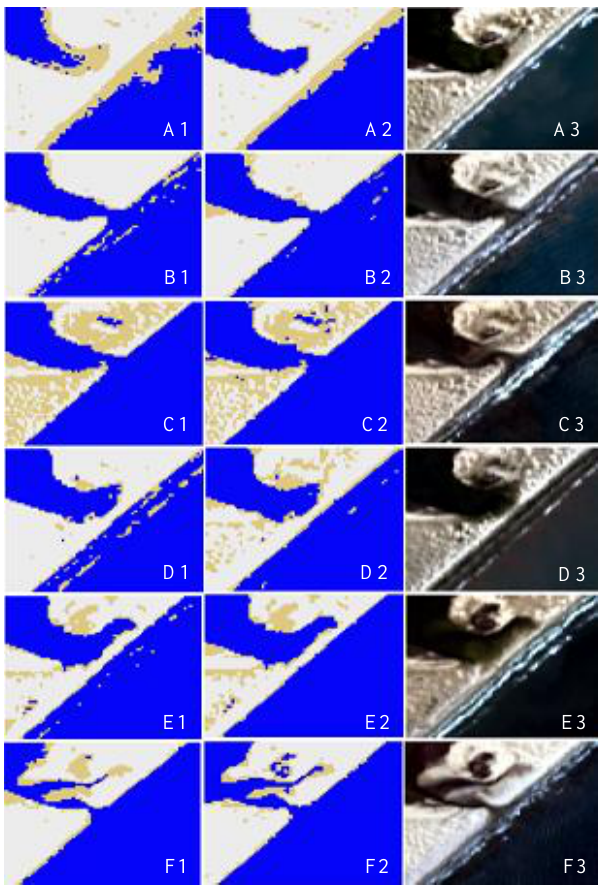
Figure 6. The clusters map for each date (A-F) for the band 6 (1) and band 7 (2), where the water is blue, the sand is white and the wet sand is brown, and composite color image